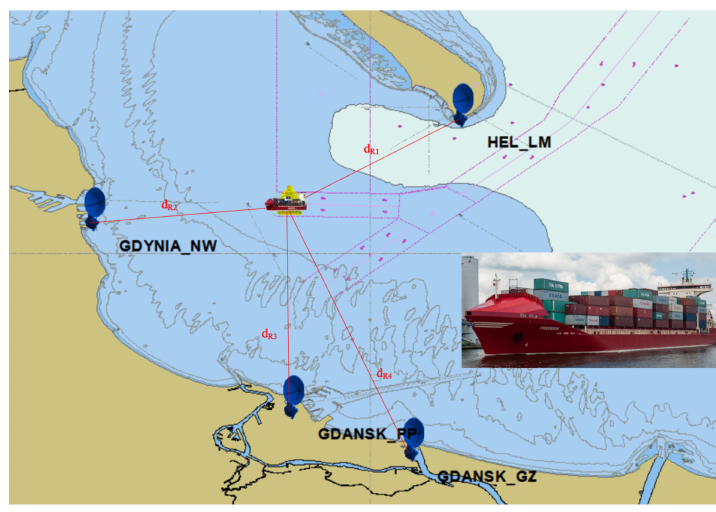
Figure 6. Measurement structure adopted in the test.